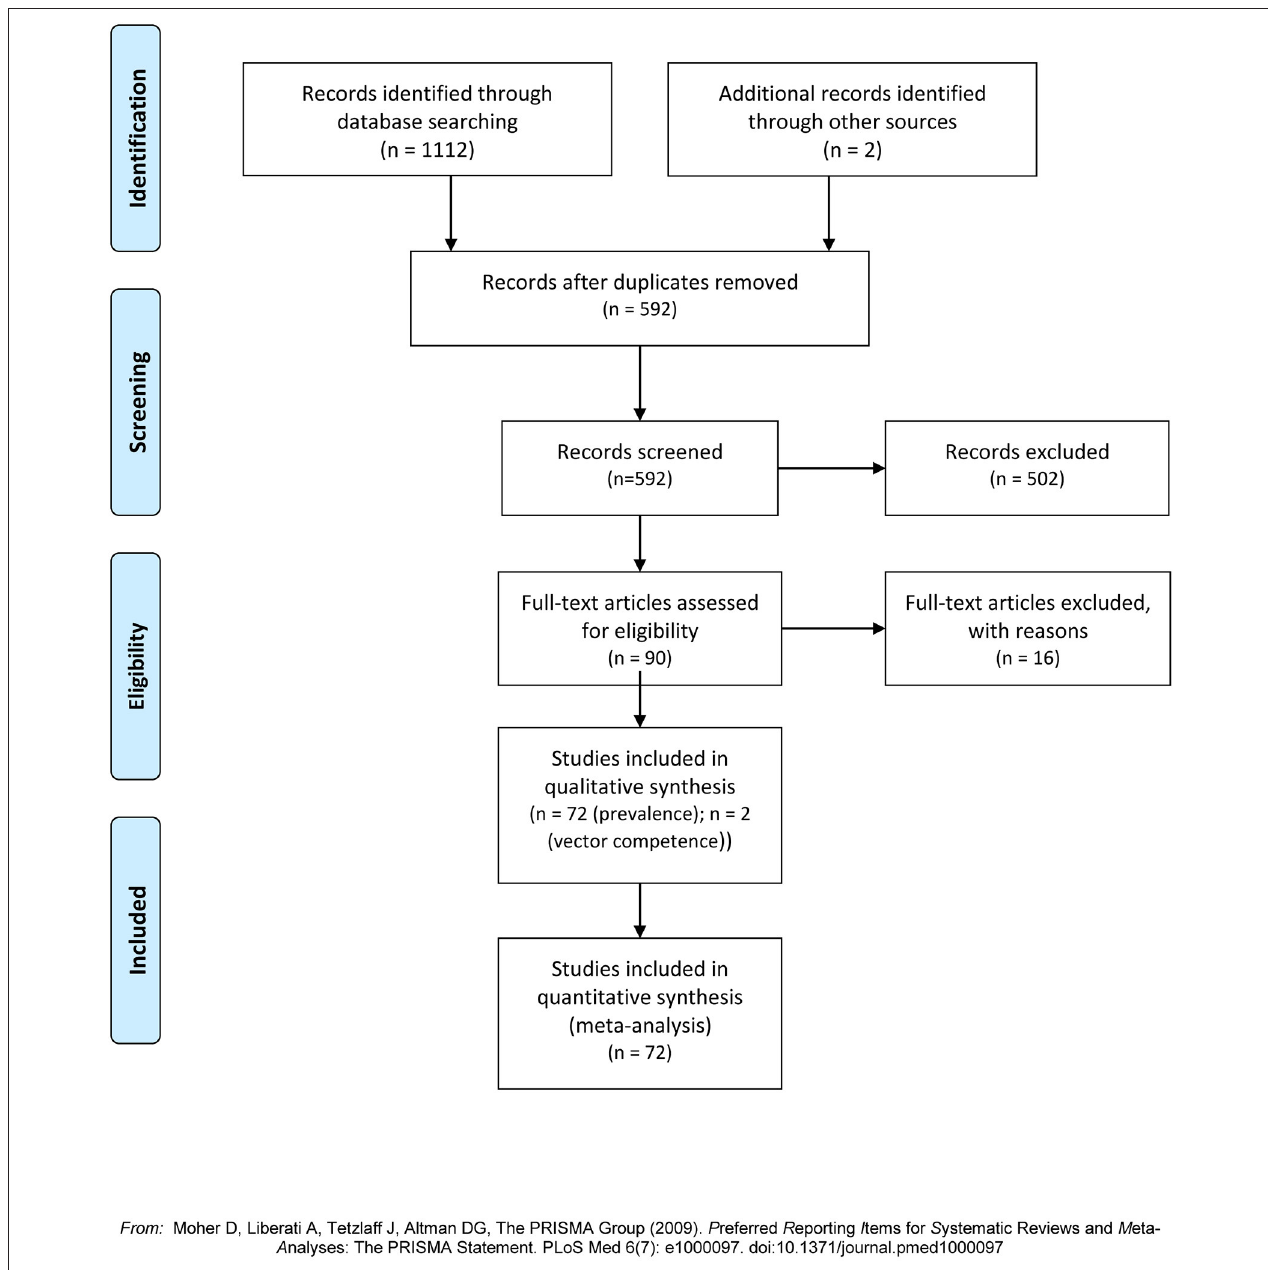
FIGURE 1 | PRISMA flow chart for selection of studies, including the reasons for exclusion from the analysis.